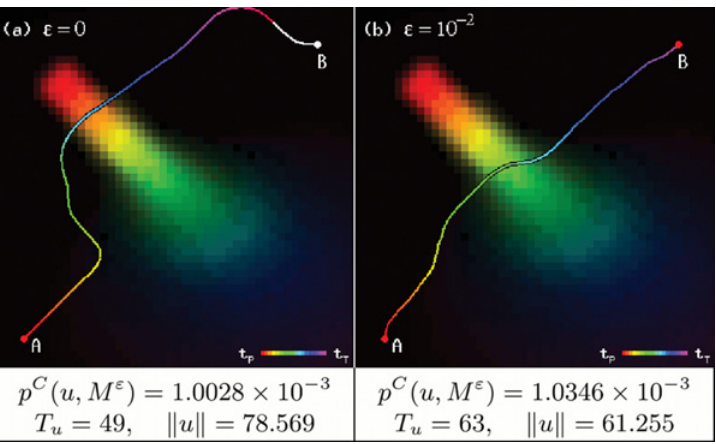
Fig 3. Effects of minimum probability restriction parameter (cid:2) , on a trajectory from point A to point B. The white segment in (a) is the section of the trajectory that exceeds time step t T , with T = 50.